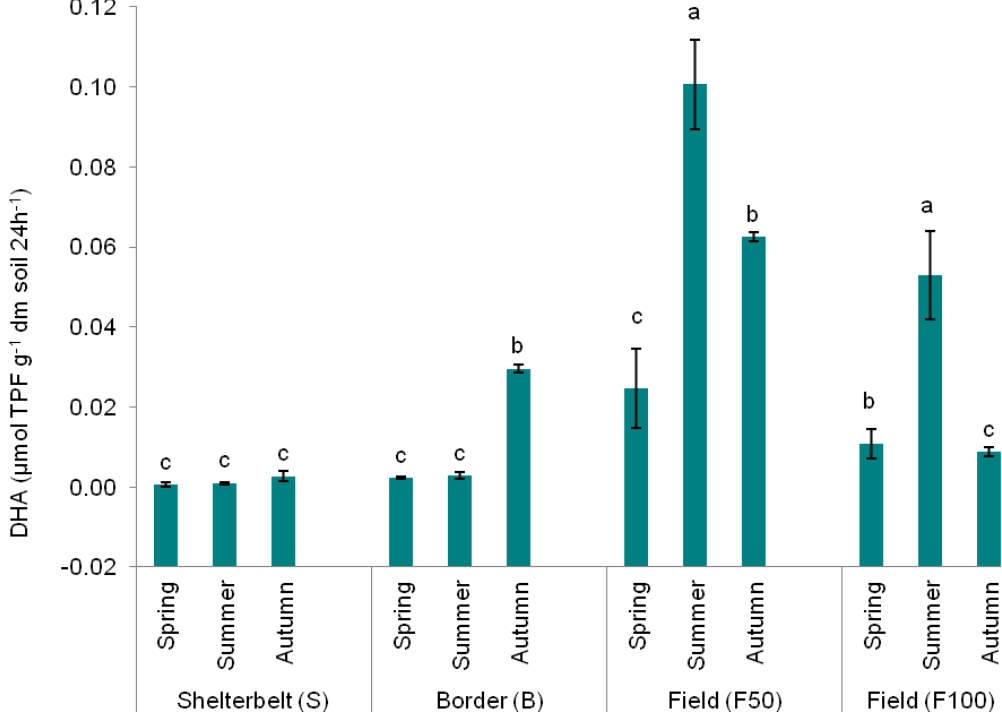
Figure 4. The enzymatic activity of dehydrogenase (DHA) in Luvisol on three different research dates (average values ± standard deviation; n = 3). Different letters indicate significant differences; ANOVA carried out separately for measuring point and sampling time, p < 0.05.